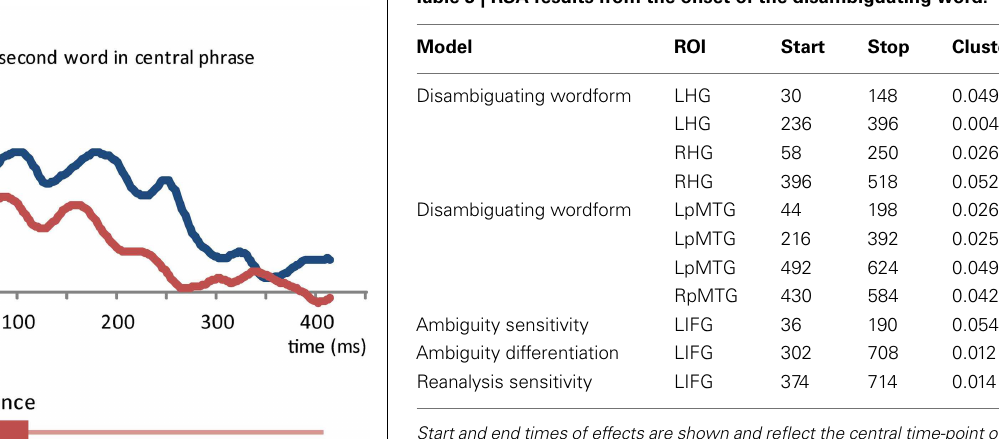
Table 3 | RSA results from the onset of the disambiguating